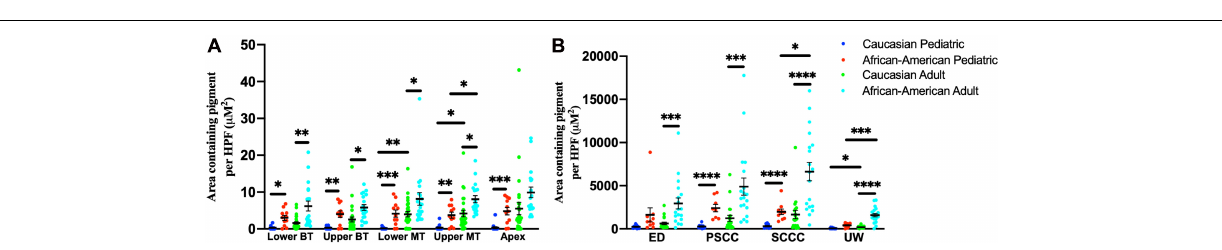
FIGURE 6 | Pigmentation within the stria vascularis (A) and vestibular system (B) of human temporal bones, broken down by age and race. Error bars indicate standard error. SV, stria vascularis, BT, basal turn; MT, middle turn; ED, endolymphatic duct; PSCC, posterior semicircular canal; SCCC, superior semicircular canal; UW, utricle wall. ∗ Adjusted p -value < 0.05, ∗∗ adjusted p -value < 0.01, ∗∗∗ adjusted p -value < 0.001, and ∗∗∗∗ adjusted p -value <